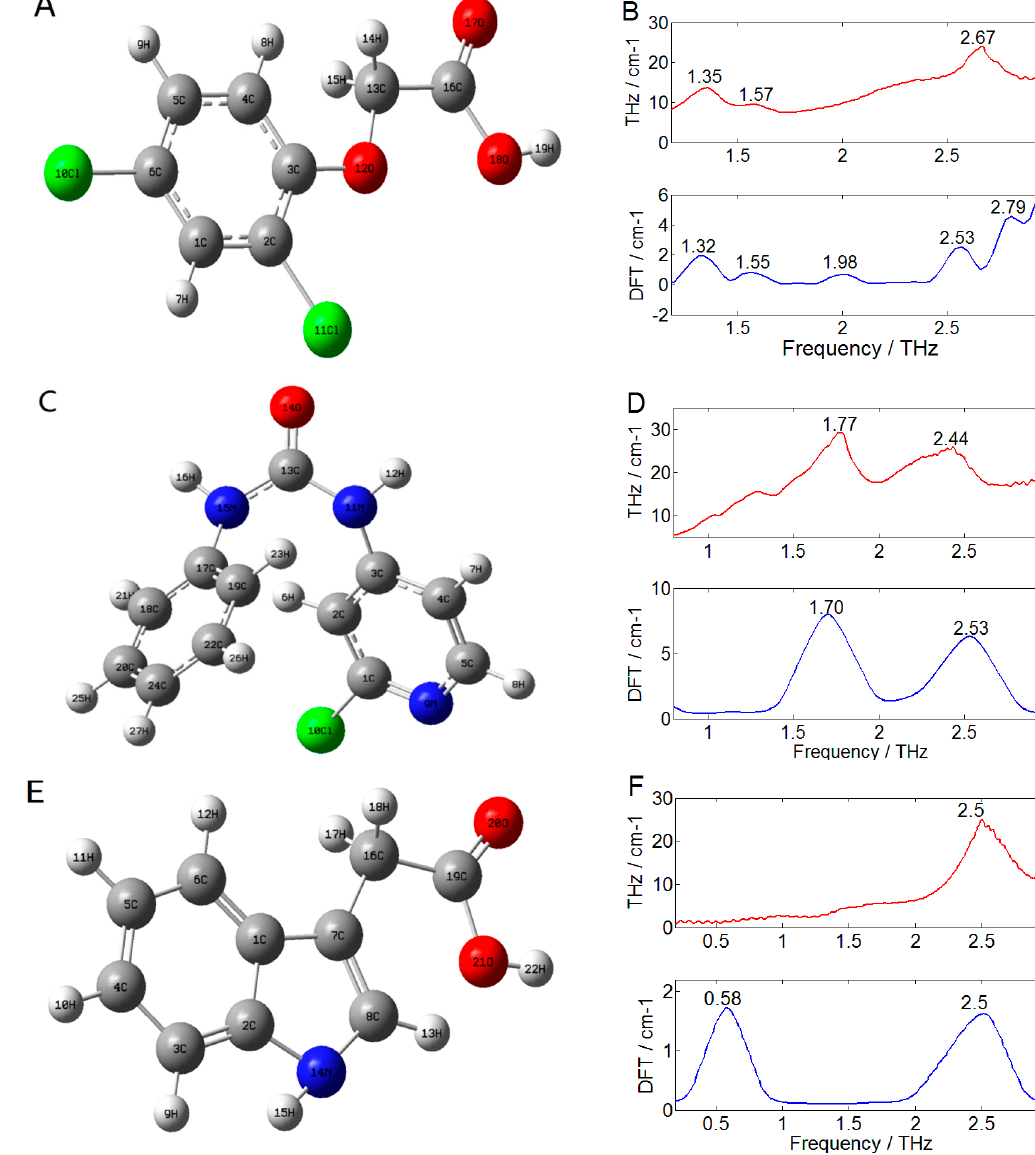
Figure 4. Calculated molecule and absorption spectra of three PGRs. ( A ) 2,4-D molecule; ( B ) 2,4-D spectra; ( C ) CPPU molecule; ( D ) CPPU spectra; ( E ) IAA molecule; ( F ) IAA spectra.